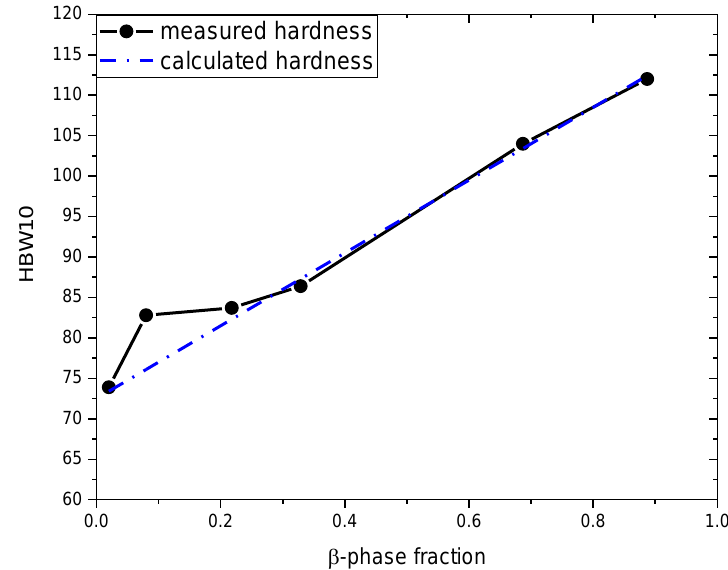
Figure 9. Macroscopic hardness of ZnAl x Cu0.7 alloys for different β-phase fractions, i.e., different Al compositions.